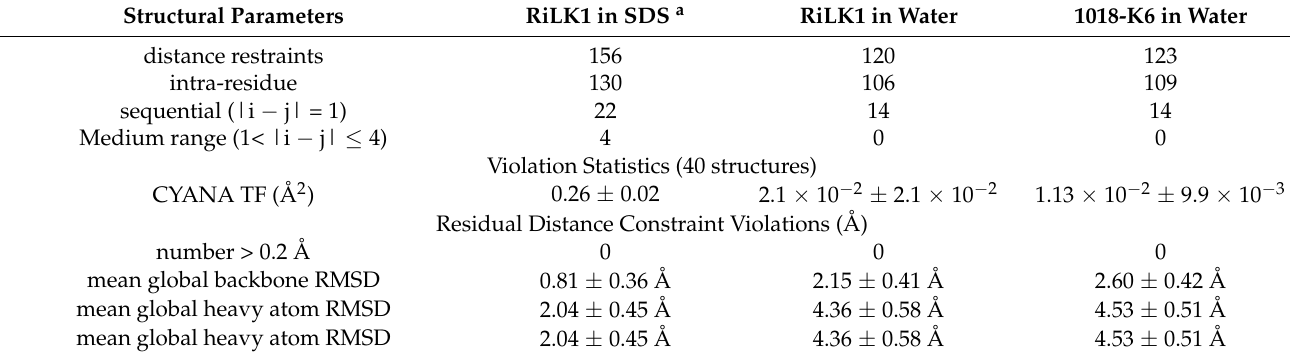
Table 1. CYANA structural statistic of RiLK1 and 1018-K6 in different